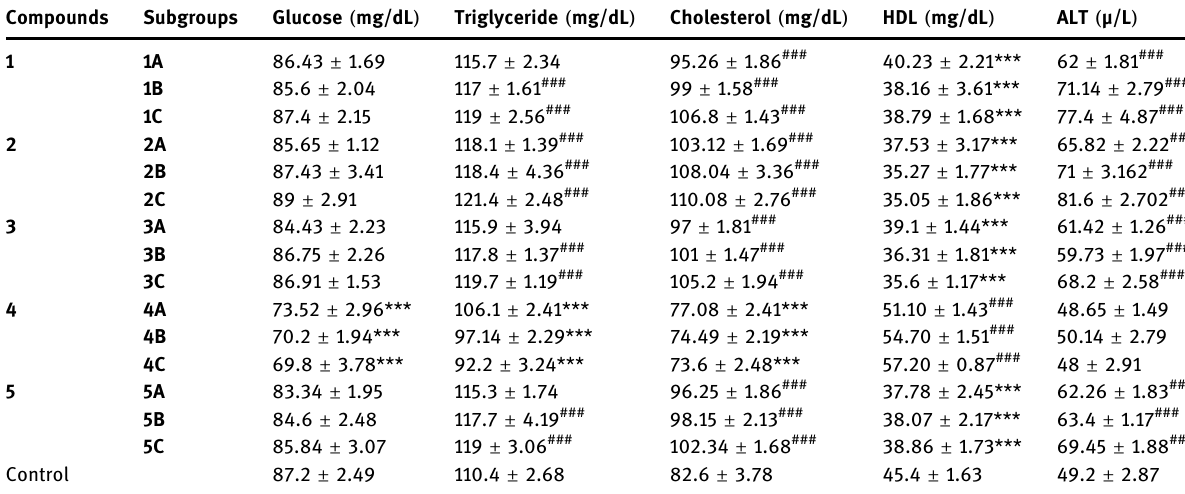
Table 8: E ff ect of thiourea derivatives on biochemical parameters in mice after 30 days of administration Compounds